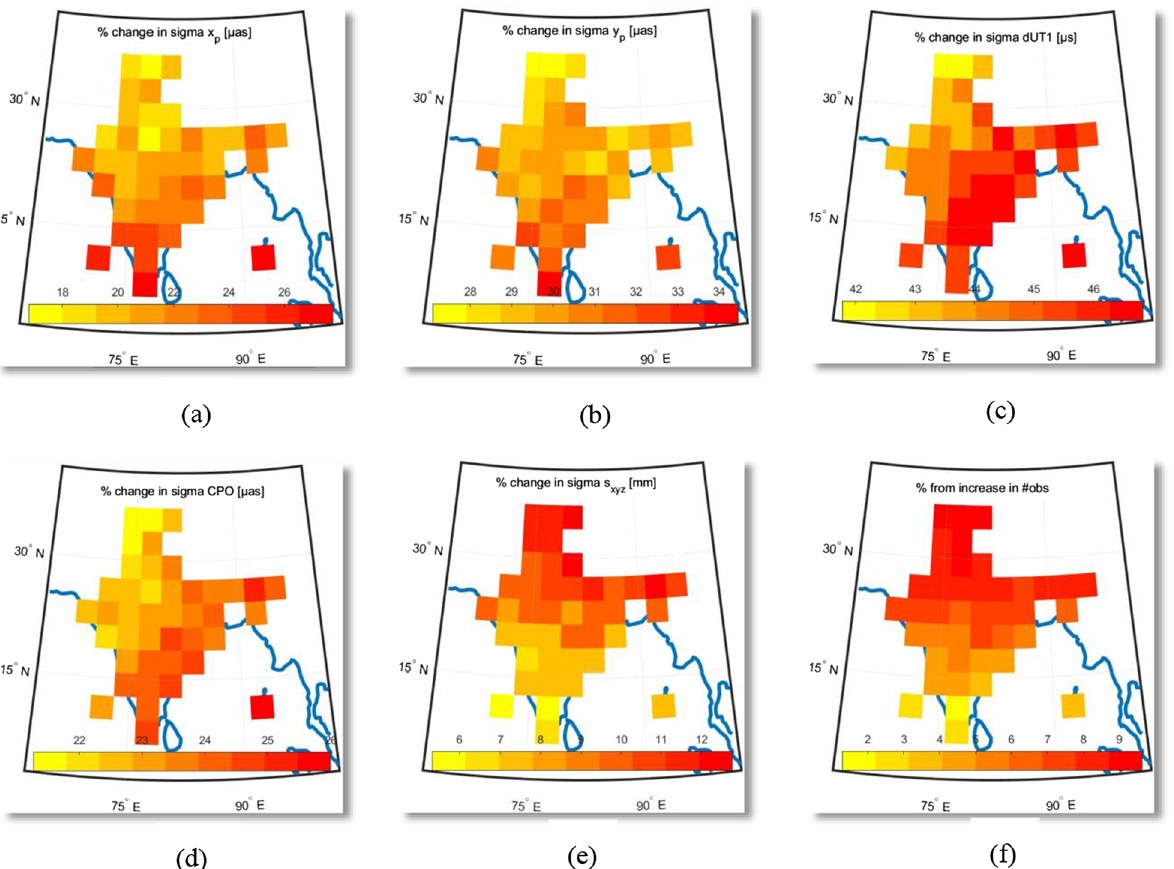
Fig.6 a – e Percentage improvement in the mean formal error (sigma) of geodetic parameters in the second scenario; f expected improvement percentage from the increase in